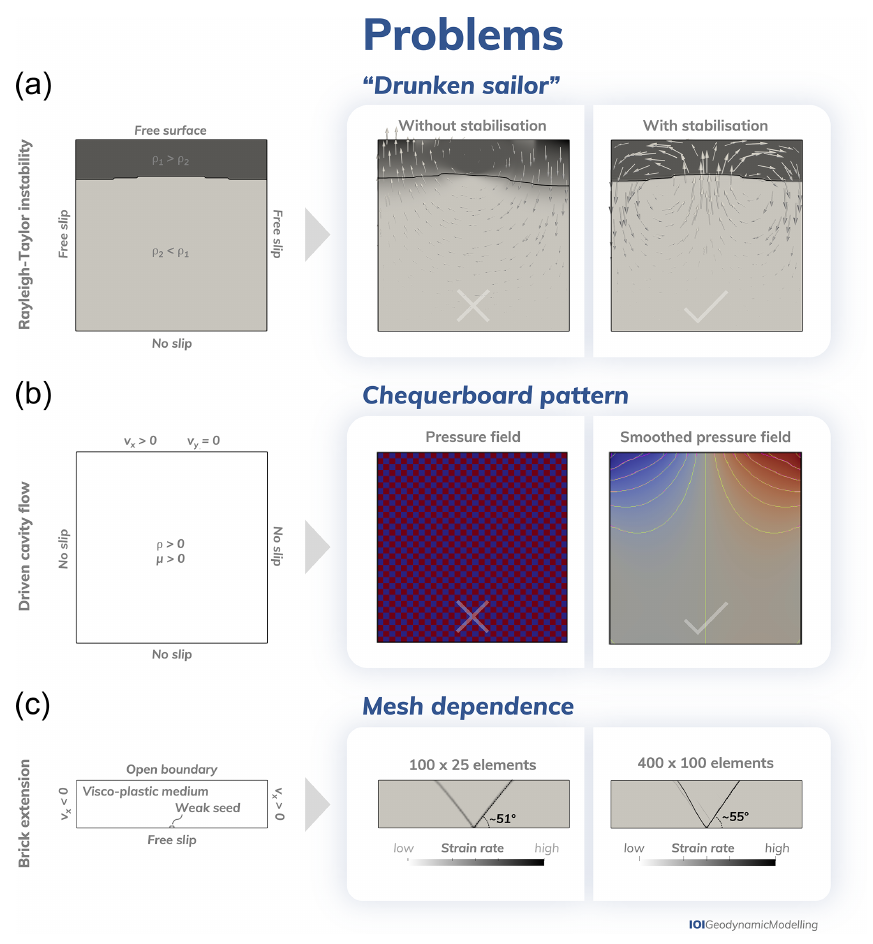
Figure 10. Common numerical modelling problems. (a) Rayleigh–Taylor instability problem demonstrating the drunken sailor instability arising from a numerical time step that is too large (e.g. Kaus et al., 2010; Rose et al., 2017) for the stress perturbations deriving from surface topography due to the typical crust–air density difference being much larger than density differences inside the Earth. The large time step size leads to a fast sloshing of the surface, as seen from the velocity vectors. Note that the vectors in the model without stabilisation are scaled down by 1 order of magnitude. The high velocities also lead to overshooting of the advected compositional field; i.e. values exceed 1. When stabilisation is applied, a time step of 5000 years leads to a stable uprising in the centre of the domain. (b) The lid-driven cavity model (e.g. Erturk et al., 2005; Erturk, 2009; Thieulot, 2014) demonstrates the need for smoothing the pressure field when using Q 1 × P 0 elements in the finite-element method (in this case 32 × 32 elements). Using an LBB stable element, like Q 2 × Q 1 or Q 2 × P − 1 , avoids this problem (Donea and Huerta, 2003). (c) Extension of a visco-plastic medium with shear bands forming at a viscous weak seed along the bottom (e.g. Lemiale et al., 2008; Kaus, 2010; Spiegelman et al., 2016; Glerum et al., 2018). The angle and thickness of the shear bands are dependent on the mesh resolution. Regularised plasticity implementations and sufficient resolution are required to achieve convergence with resolution (e.g. Duretz et al.,